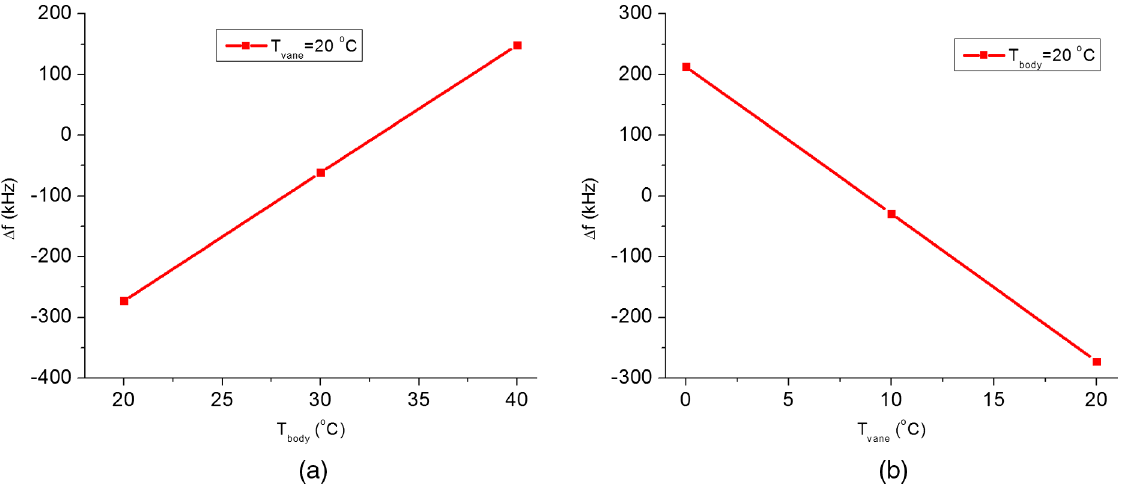
FIG. 16. RFQ frequency response to changing cooling water